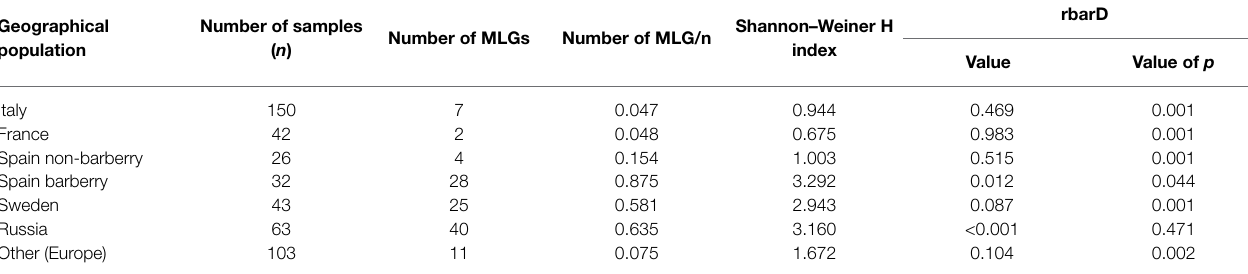
TABLE 4 | Genetic diversity of geographical spaced populations of Puccinia graminis f.sp. tritici in Europe and Russia. Geographical